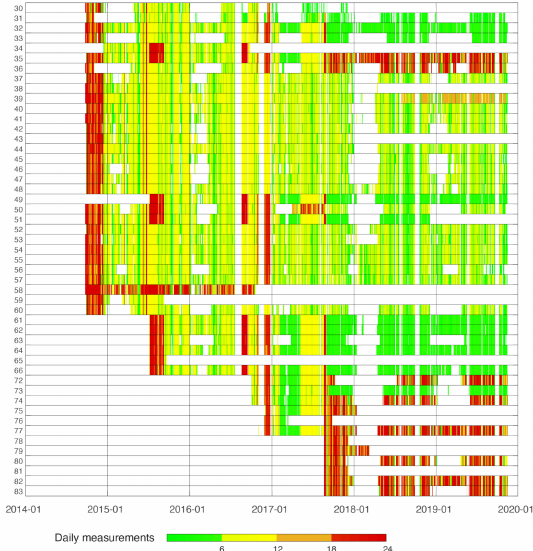
Figure 6. Availability of TPS2 (Leica TM50) measurements over the monitoring period. The target ID is shown in the y -axis (for the location of targets see Figure 1), while the colormap shows the amount of daily measurement cycles